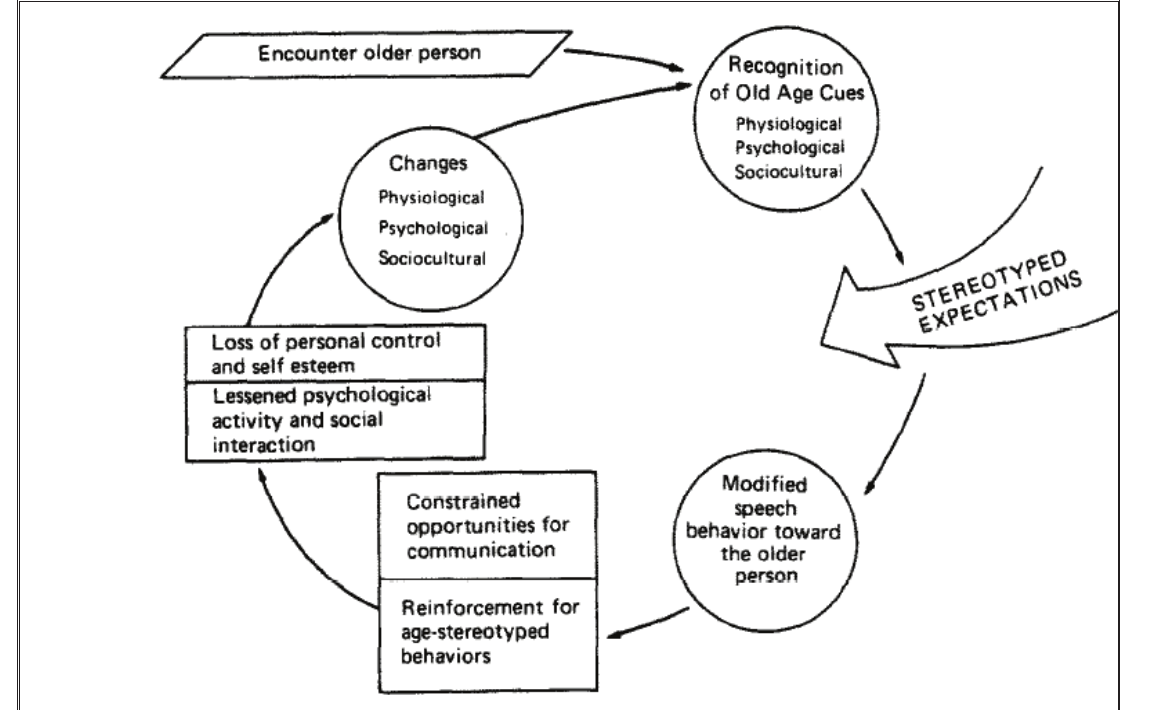
Figure 1 . Communication Predicament of Aging Model (CPAM) (Ryan et al., 1986). Reprinted with permission from Elsevier